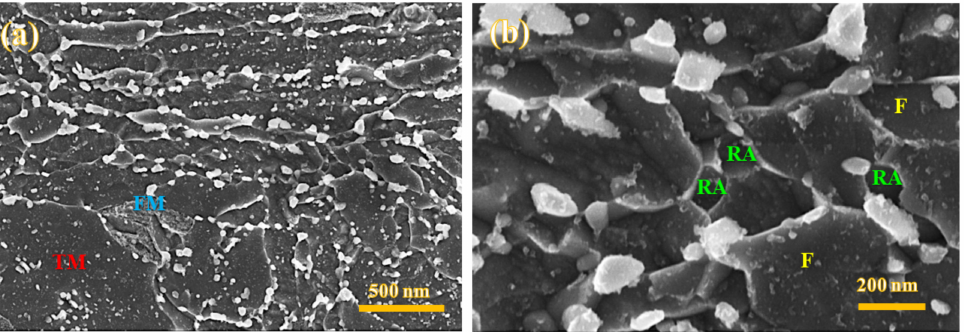
Figure 6. FE-SEM micrographs of the Def-A650 sample showing TM, FM, and carbides on the martensite lath boundaries and inside the laths ( a ), recrystallized ferrite (F), and equiaxed RA nucleated on carbide/ferrite boundaries along with very fine precipitates inside the F and RA grains ( b